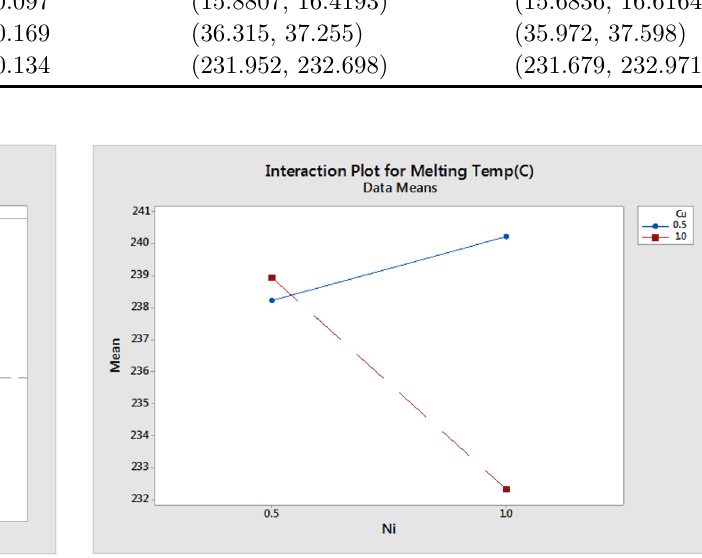
Fig. 5. Interaction plot for melting temperature.